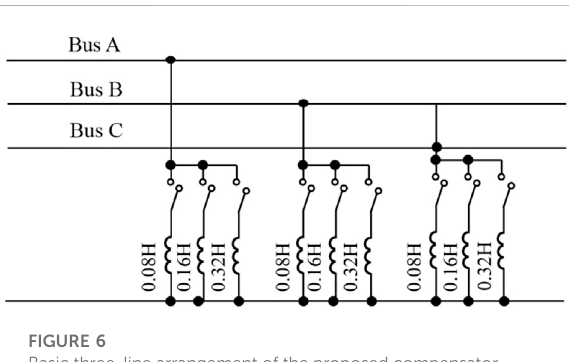
FIGURE 6 Basic three-line arrangement of the proposed